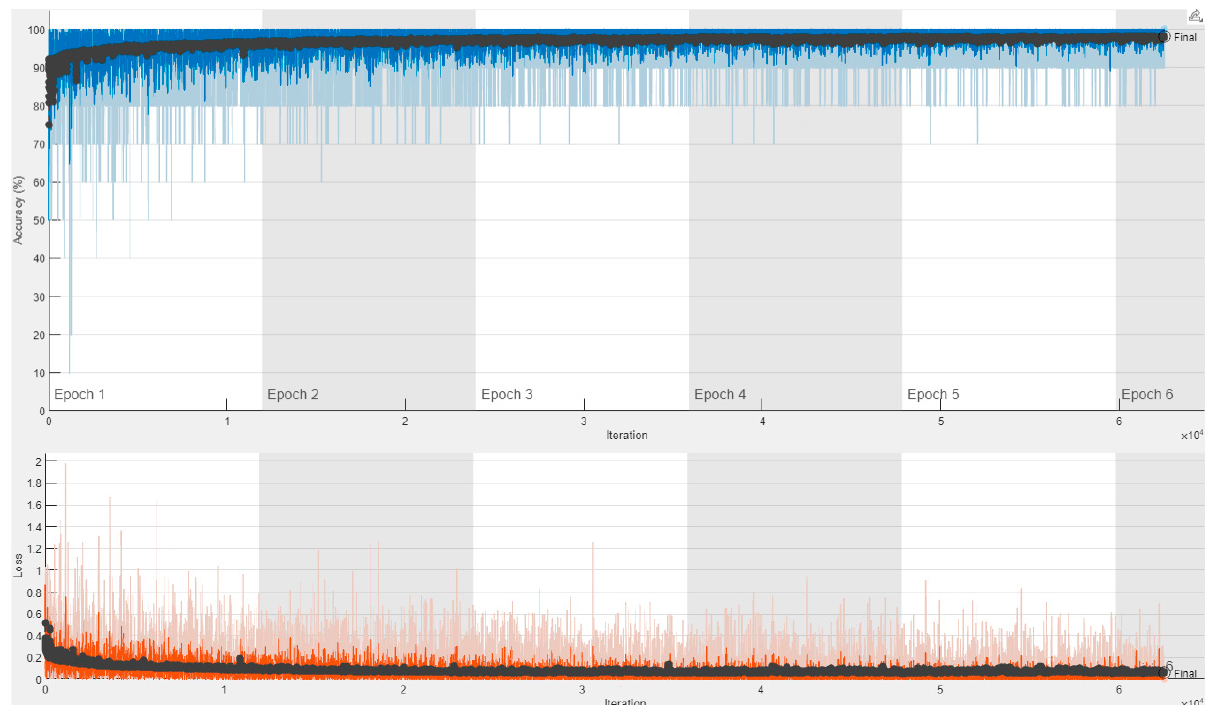
Figure 16. Training process result for ResNet18 with 132,968 spectrogram images in a trial on the 10 ‐ FCV.